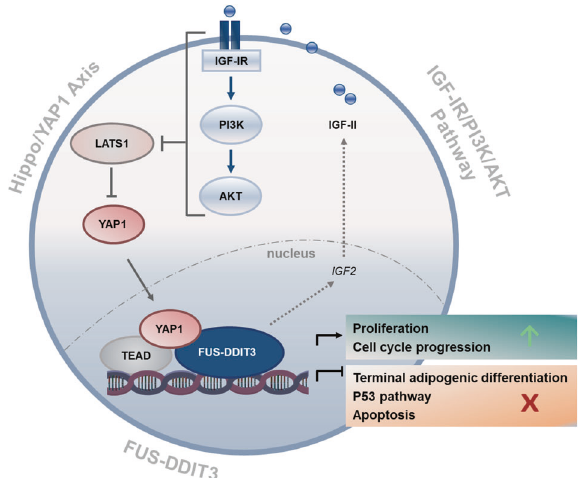
Fig. 6 Oncogenic circuit involving FUS-DDIT3, the IGF-IR/PI3K/ AKT pathway, and the Hippo/YAP1 axis in MLS. FUS-DDIT3- dependent induction of IGF2 establishes an autocrine IGF-II/IGF-IR signaling loop, contributing to IGF-IR/PI3K/AKT pathway activation in MLS. IGF-IR and PI3K-transmitted signals interfere with the Hippo kinase LATS1, which is a direct negative regulator of YAP1, thereby promoting nuclear accumulation of transcriptionally active YAP1. In the nucleus, FUS-DDIT3 complexes with YAP1/TEAD. FUS-DDIT3 and YAP1 co-regulate oncogenic gene expression programs affecting proliferation, cell cycle progression, apoptosis, and